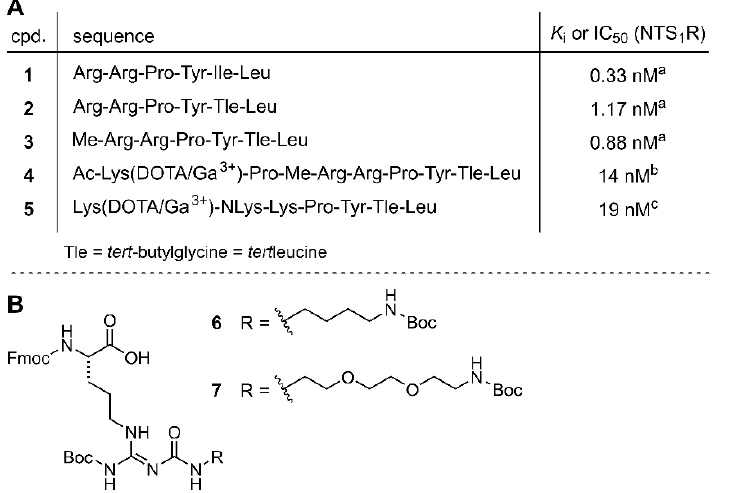
Figure 1. ( A ) Amino acid sequences and NTS 1 R affinities of NT(8-13) ( 1 ), NT(8-13) derivatives 2 and 3 , and NT(8-13)-derived potential PET ligands 4 and 5 . ( B ) Structures of the reported arginine building blocks 6 and 7 (Keller et al. [39]) which were applied in SPPS for the preparation of amino-functionalized precursor peptides. a K i value; Schindler et al. [40], b IC 50 value; Alshoukr et al. [41], c K i value; Maschauer et al. [42].